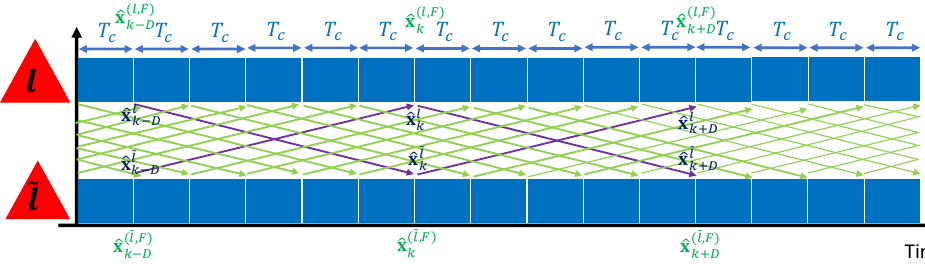
Figure 3. Soft Fusion with Predict-and-Go principle. (cid:96) and ˜ (cid:96) are the indices of two partial